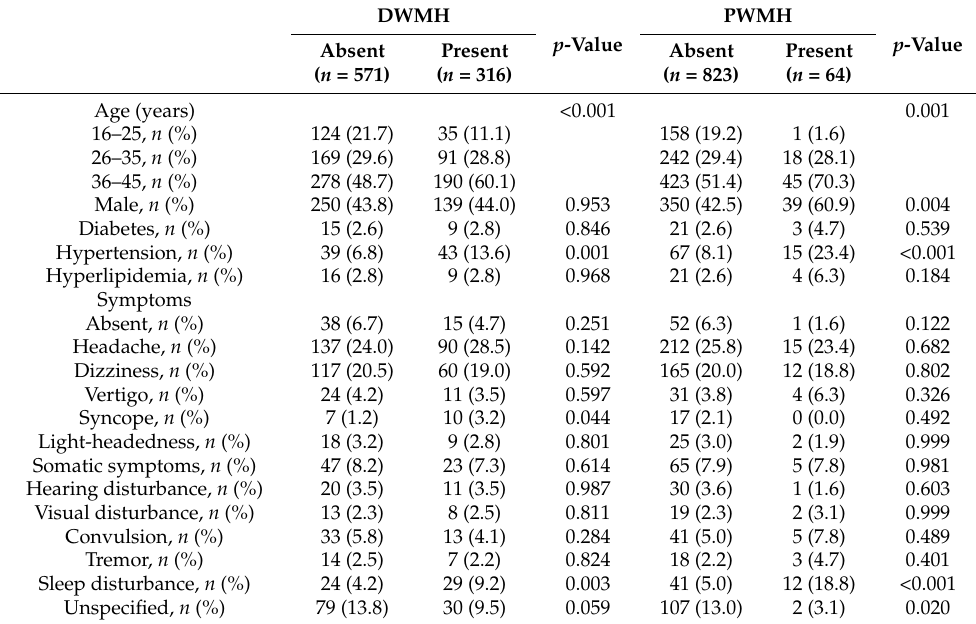
Table 3. Results of the chi-square analysis of the differences in the risk factors and presence of